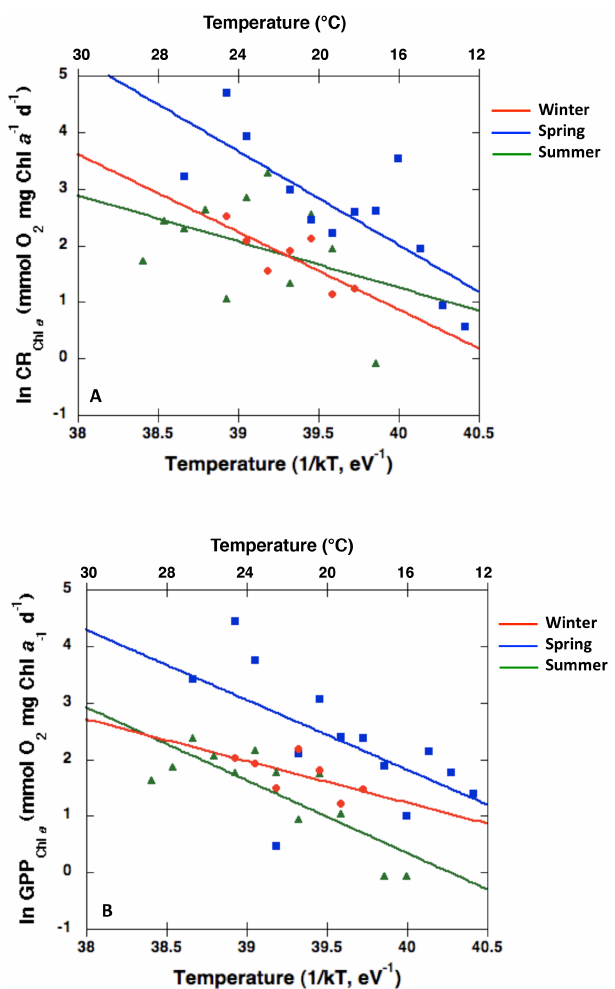
Figure 4. Arrhenius plots showing the relationship between Chl a - specific average rates (a) CR Chl a and (b) GPP Chl a within 1 ◦ C bins and the inverted water temperature (1 /kT , where k is the Boltz- mann’s constant, 8.617 × 10 − 5 eVk − 1 , and T is the water temper- ature in ◦ K) for legs 1, 2 and